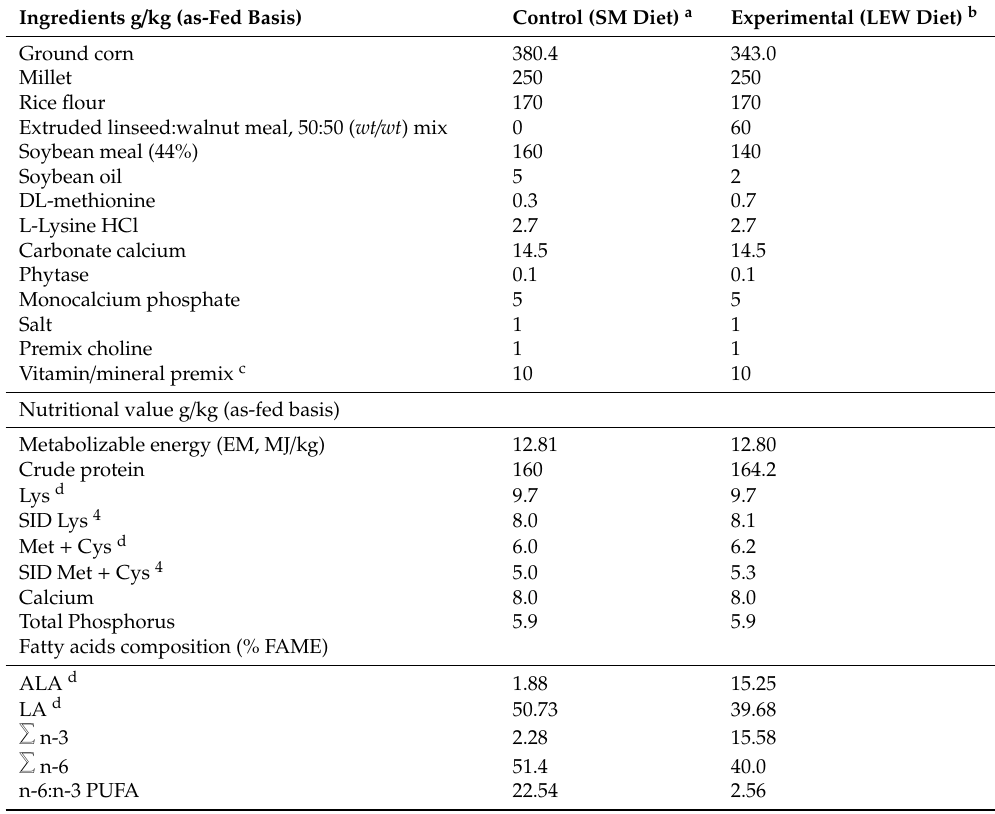
Table 1. Structure and nutritional value of experimental diets.